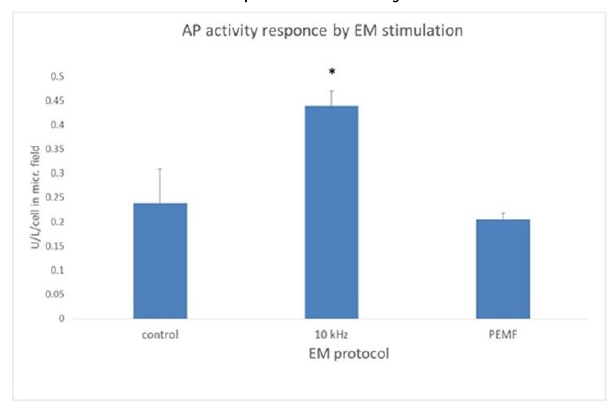
Figure 5 : Alkaline phosphatase (AP) cellular activity is significantly increased following exposure to the 10 kHz alternating electromagnetic field AEMF protocol. Mean values with an indication of SEM (standard error of the mean), by the vertical bars, are presented. PEMF: Pulsed electromagnetic field - 10 Hz/5